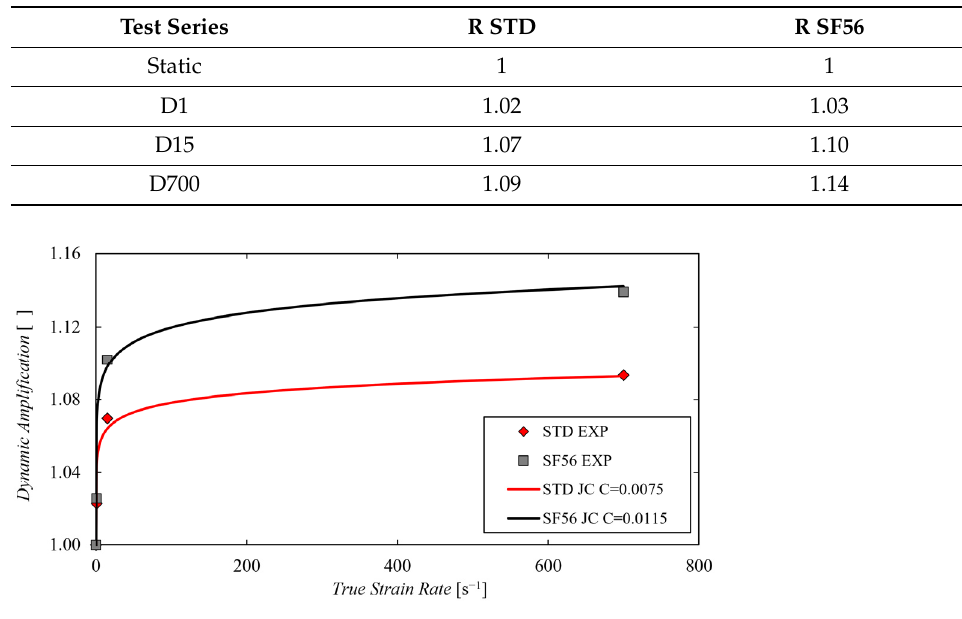
Figure 7. Experimental dynamic amplification obtained with the standard and the SF56 parameter sets (scattered series) and their best approximation considering the Johnson–Cook dynamic term (solid lines).